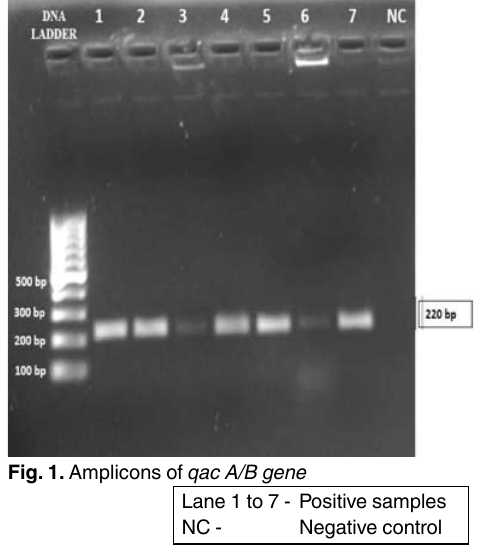
Fig. 1. Amplicons of qac A/B